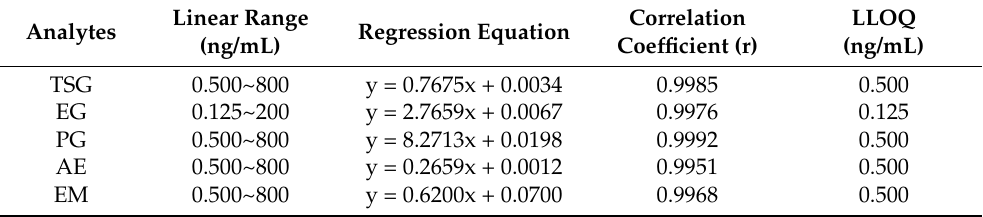
Table 1. The results of linear ranges, regression equations, and LLOQs of five detected compounds.